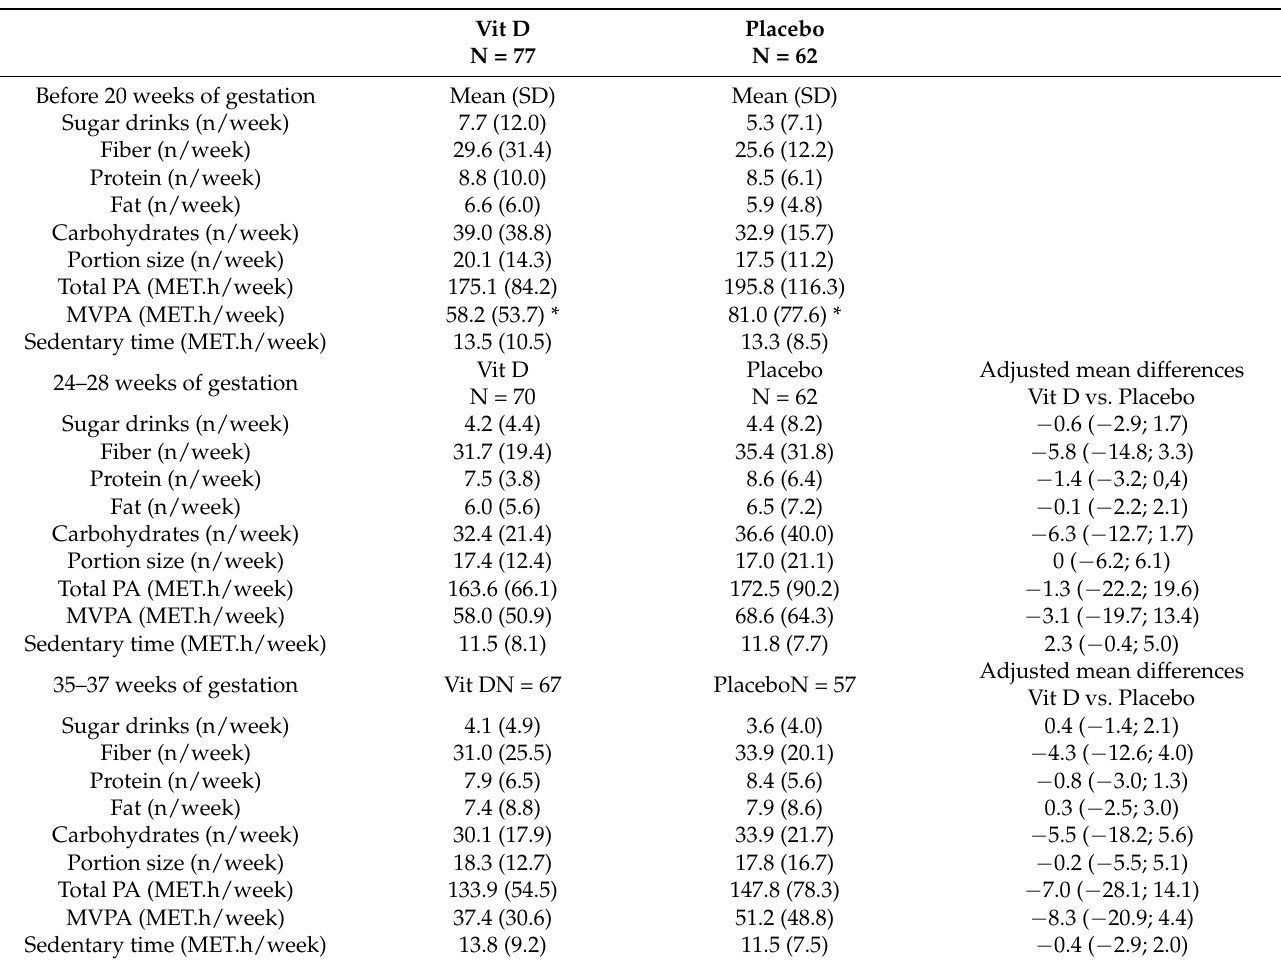
Table 3. Nutritional and physical activity information in the two intervention groups and mean differences between intervention groups adjusted for baseline